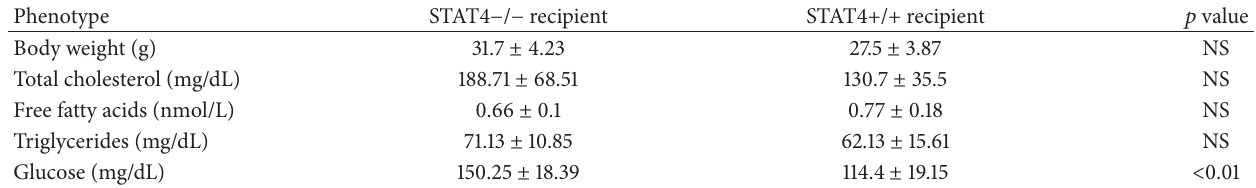
Table 1: Body weight, plasma lipids, and glucose for STAT4-deficient or STAT4-sufficient mice following bone marrow